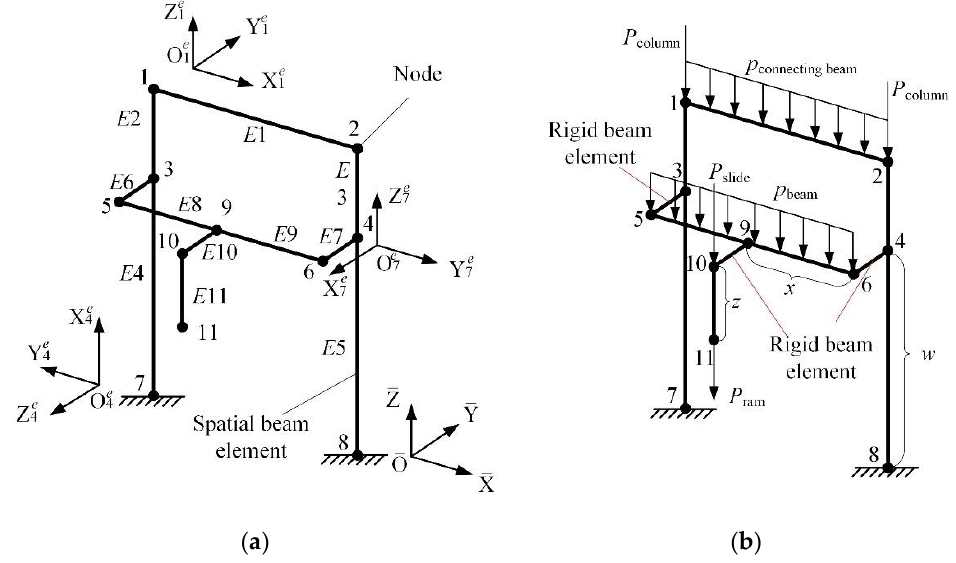
Figure 5. Model of HDVMC based on spatial beam element. ( a ) Element node information and coordinate system definition. ( b ) Force analysis under